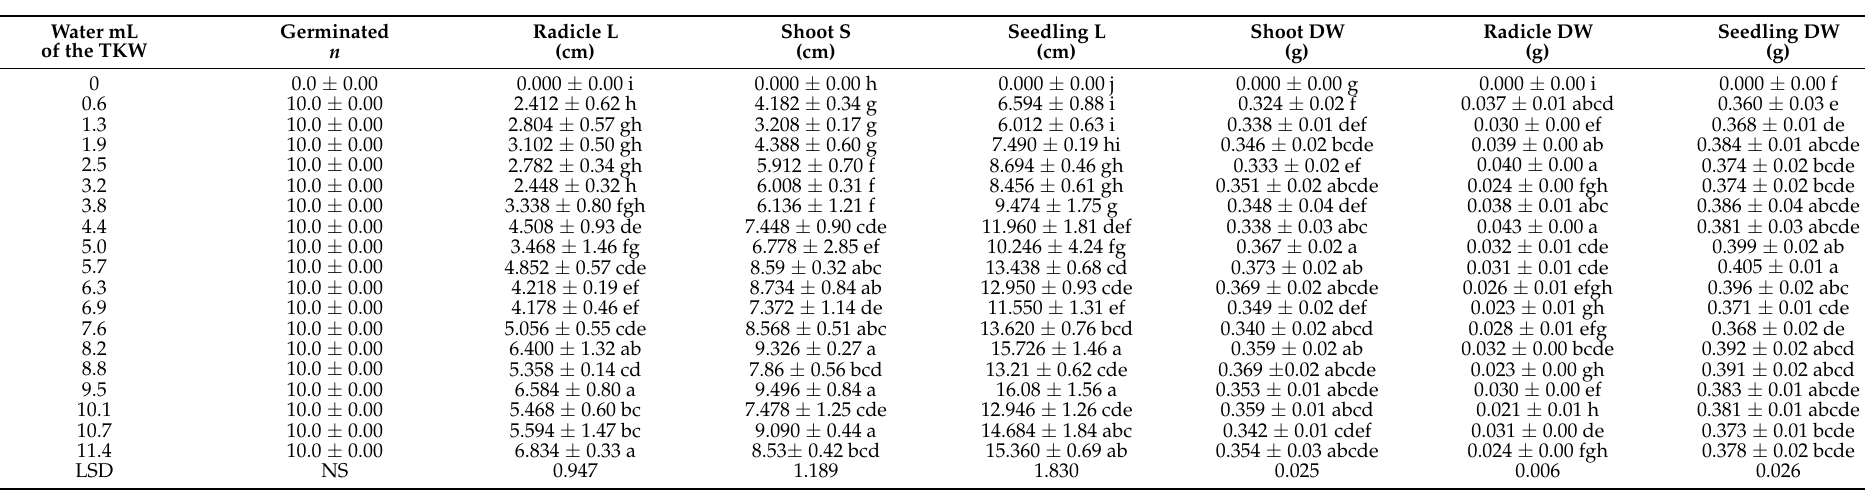
Table 3. Mean comparison of germination and seedling growth characteristics for varying amounts of water depending on